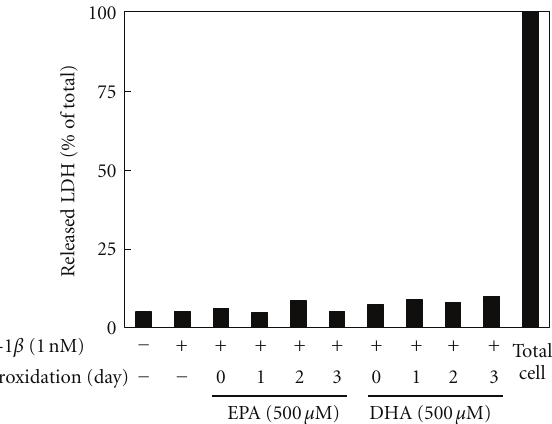
Figure 4: Correlation between peroxidation levels of EPA/DHA and inhibition of NO production. Cells were treated with IL-1 β (1nM) in the presence or absence of peroxidized EPA (open circles) and DHA (closed squares) (each, 500 μ M) for 10h. Peroxidation levels of EPA/DHA, μ M of MDA concentration equivalent per EPA/DHA (500 μ M); production of NO, n mole of nitrite/10 6 cells in the culture medium.